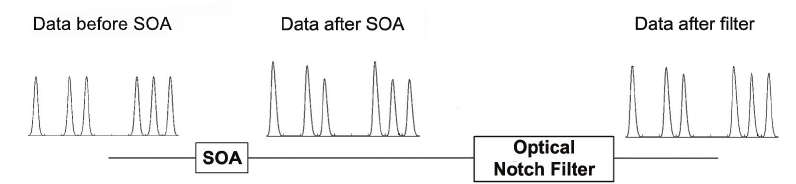
Figure 3. Data amplification in SOA with pattern-dependent output distortion and compensation by optical notch